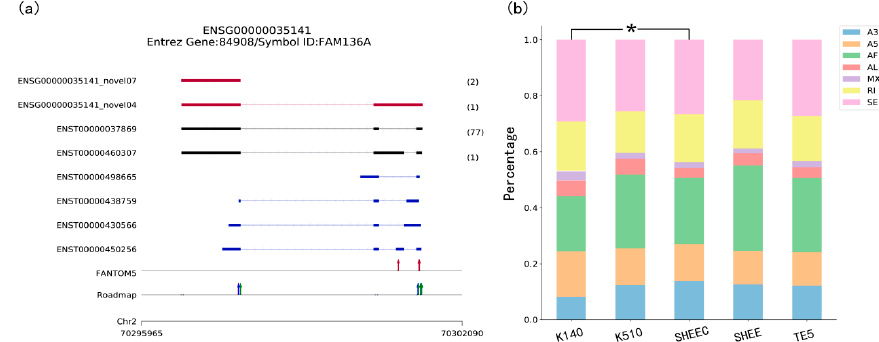
Figure 2. Visualization in TGStools. ( a ) Example of isoforms comparison with known genes and auxiliary annotation. Red track: Novel isoforms from TGS platform; Black track: Known isoforms identified from TGS platform. Blue track: Known transcripts annotation. The numbers of long reads detected are shown in brackets. Red arrow: Known Cap Analysis of Gene Expression (CAGE) promoters identified from FANTOM5 data; in Roadmap track, red, blue and green arrow indicated known H3K4me1, H3K4me3 and H3K27ac marks; ( b ) percentage of splicing events in each sample. The χ 2 test is used to find the significant difference among samples. Colors indicate different types of AS events. A3: Alternative 3’ splice site; A5: Alternative 5’ splice site; AF: Alternative first; AL: Alternative last exons; MX: Mutually exclusive exon; RI: Retained intron and SE: Skipped exon.